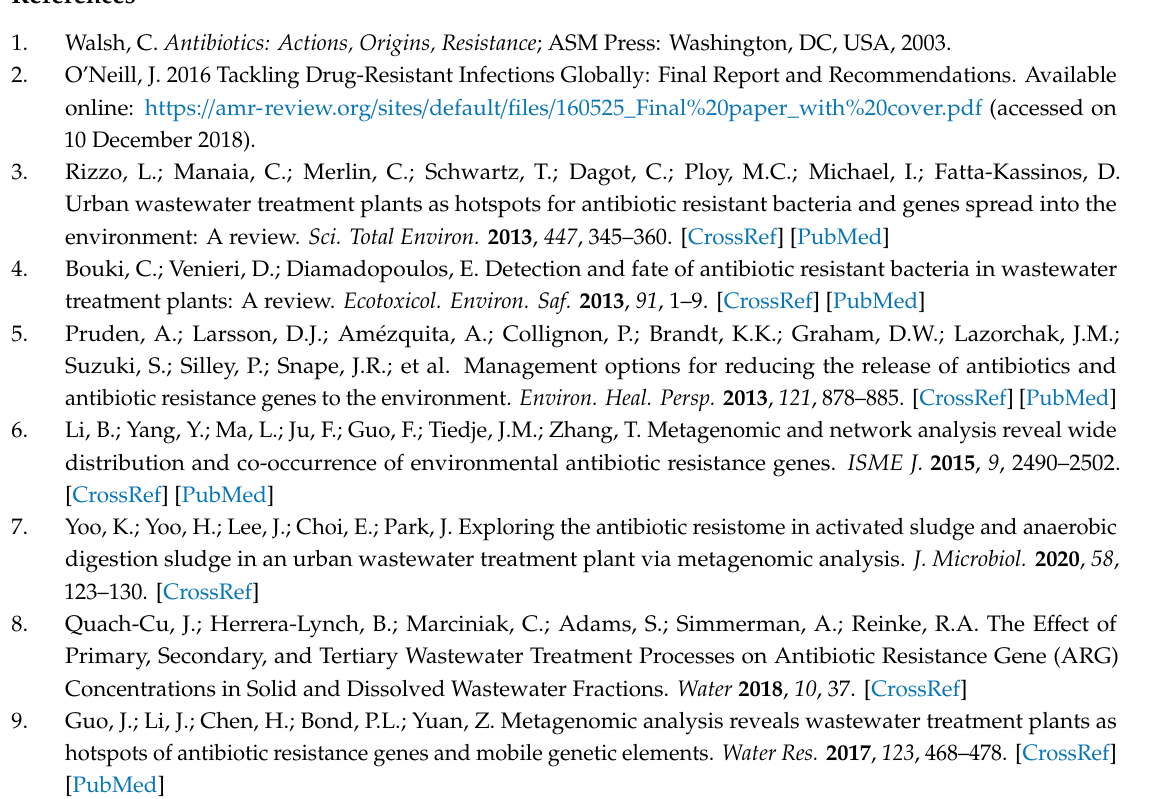
Table S1: Relative abundances of plasmids and their corresponding bacterial hosts as determined by matching metagenomic sequence reads against the NCBI plasmid genome database, Table S2: Relative abundances of the integron integrase genes and their corresponding bacterial hosts as determined by matching metagenomic sequence reads against the INTEGRALL database, Table S3: The correlation between antibiotic resistance genes (ARGs) and mobile genetic elements